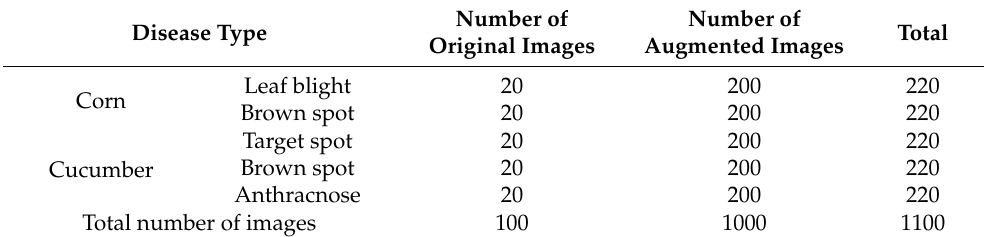
Table 1. The details of the original dataset and its augmented dataset.